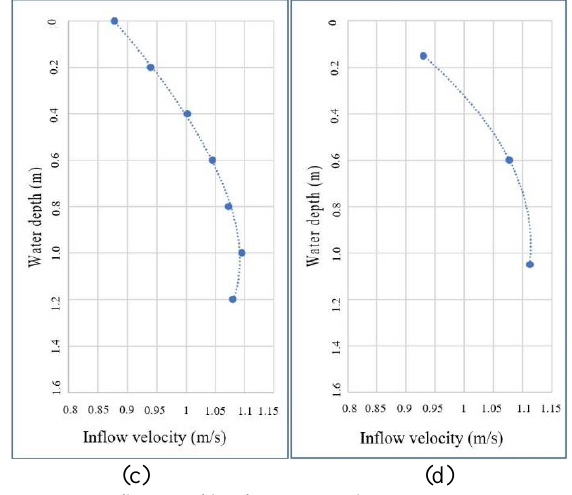
Figure 2. Inflow profiles for RW2 and NRW2. (c) is RW2 as the